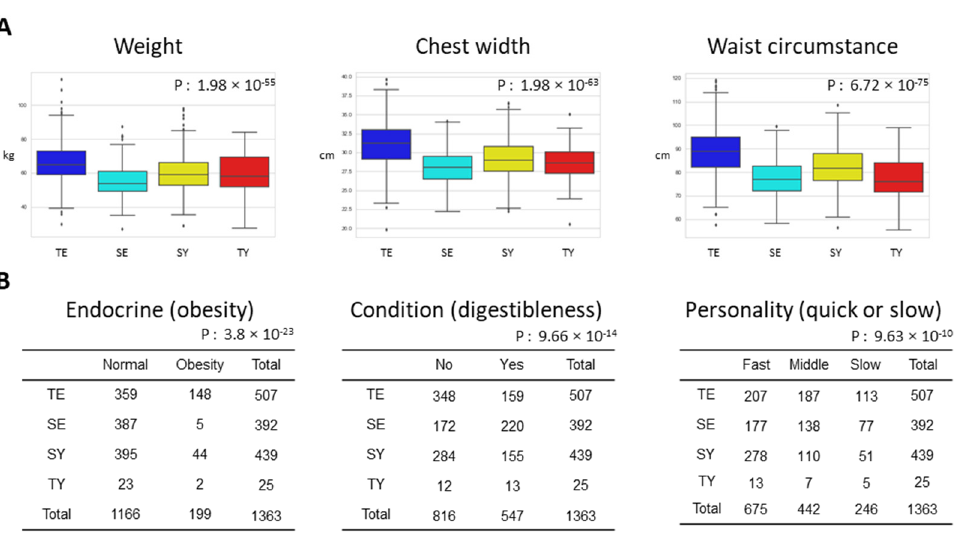
Figure 3. Representative examples of SC-associated features: ( A ) representative distributions of continuous variables according to SC type; ( B ) representative distributions of discrete variables according to SC types. The names of the feature are represented by the status of the feature class (feature name).